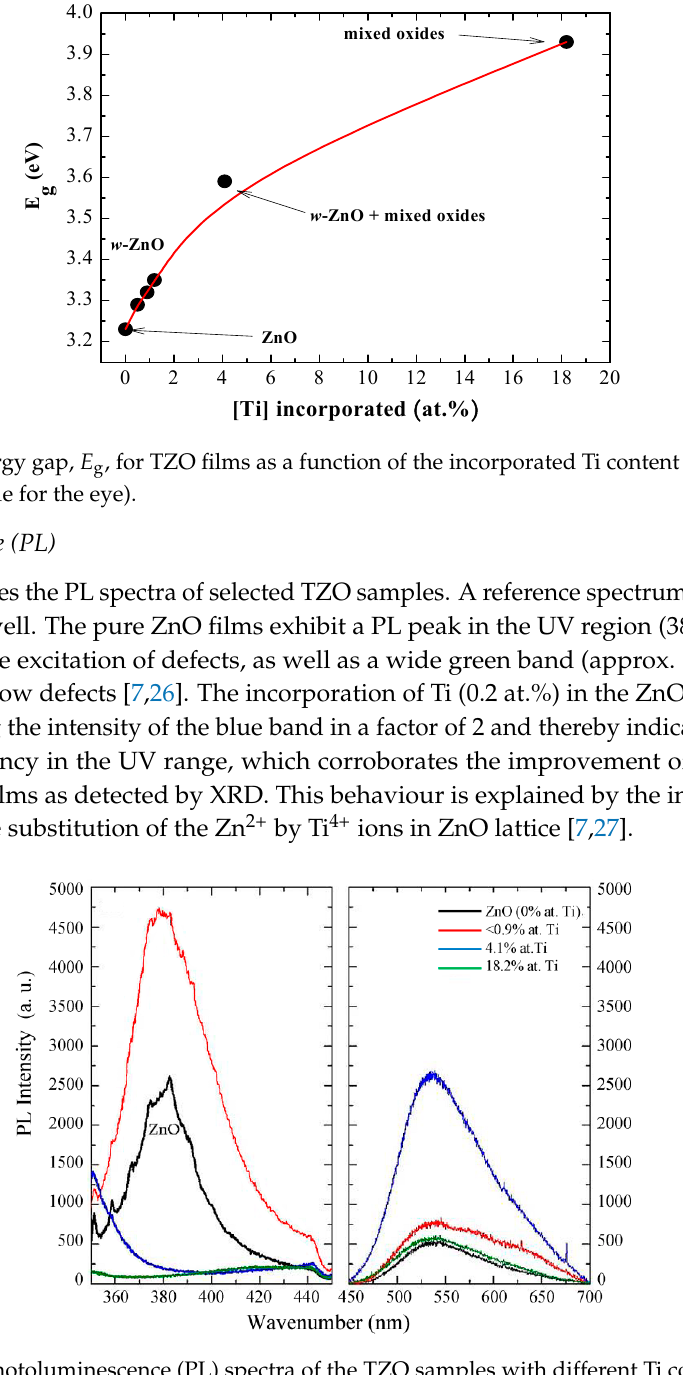
Figure 9. Photoluminescence (PL) spectra of the TZO samples with different Ti contents.